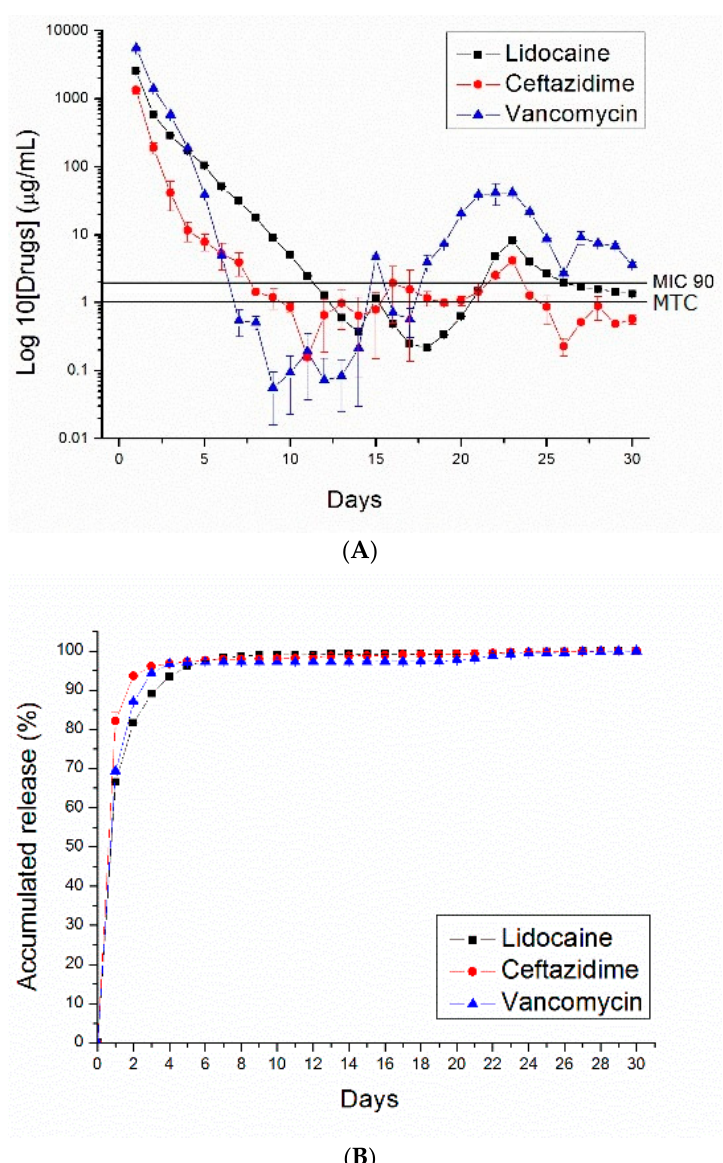
Figure 8. PLGA (50:50)—( A ) daily and ( B ) accumulated release curves of pharmaceuticals from 100 mg PLGA nano/microparticle-loaded buffered solution.